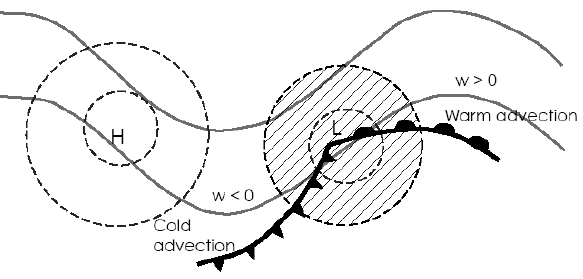
Fig. 2. Schematic presentation of a typical synoptic situation leading to precipitation in the MW and SGP. Solid lines represent 500hPa geopotential height and dashed lines represent surface pressure. Stippling denotes areas of precipitation and w indicates vertical velocity (positive upward). Based on Fig. 7.10 in Holton (1972).